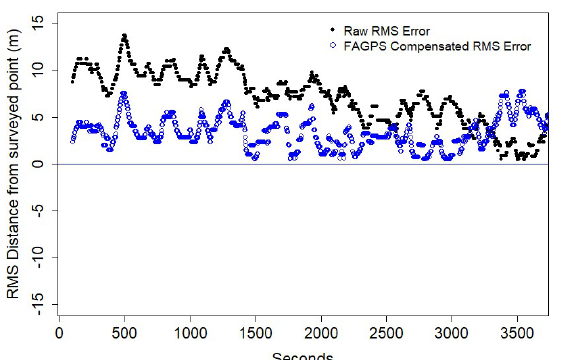
Figure 11. Results from Experiment 2 with a consistently lower error for the first 30